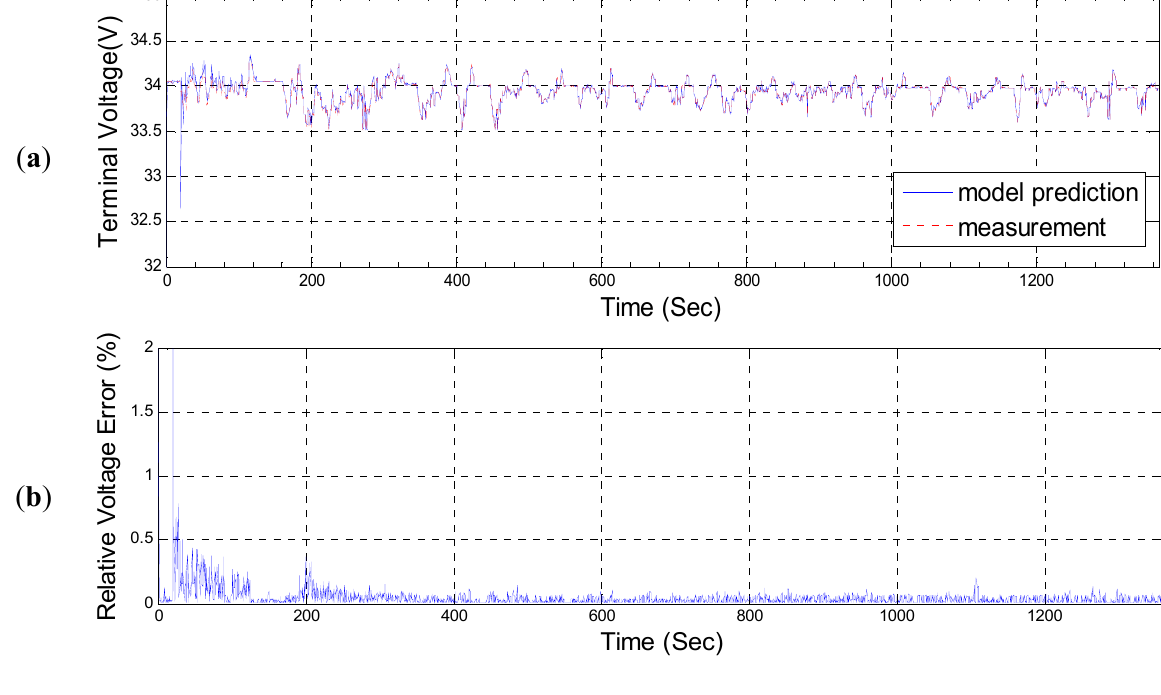
model prediction